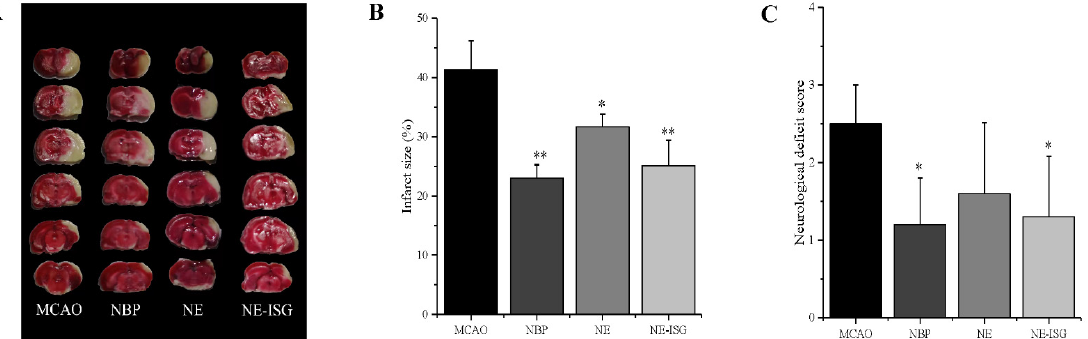
Figure 6. VOC-NE-ISG reduced brain damage and improved functional outcome after cerebral IR ( n = 10, ⎯ X ± SD). ( A ) Representative TTC stained serial coronal brain sections; ( B ) mean infarct volumes were detected; ( C ) neurological score. * p < 0.05, ** p < 0.01.